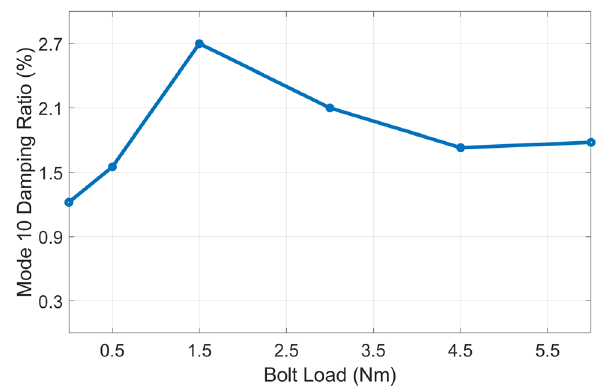
Fig. 21 The damping ratio of the 10th mode of vibration at differ- ent bolt load